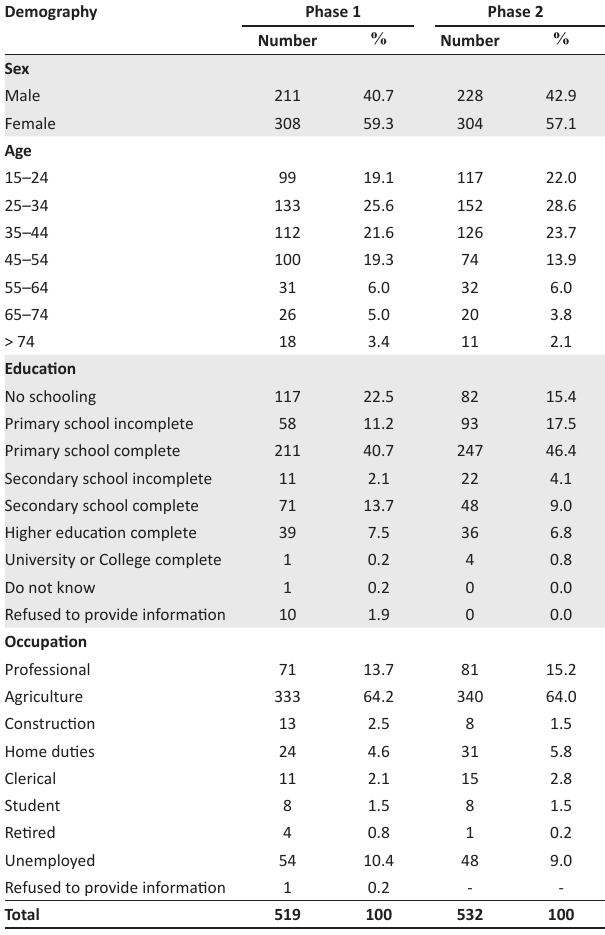
TABLE 1: Demographic profiles of participants in Phases 1 and